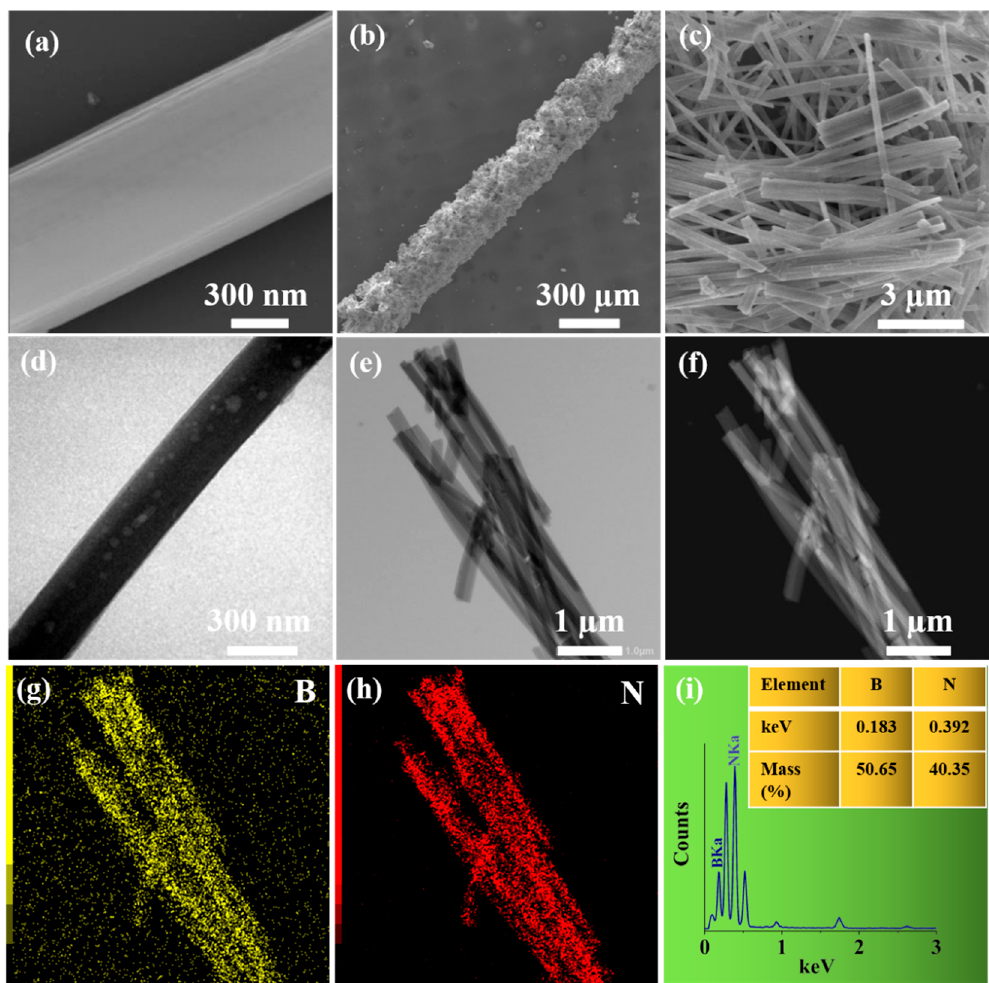
Figure 2. SEM of bare fiber ( a ); h-BN-coated fiber ( b ); h-BN coating ( c ); TEM of h-BN ( d , e ); elemental mapping of the h-BN ( f – h ); and the corresponding EDS spectra of h-BN ( i ).